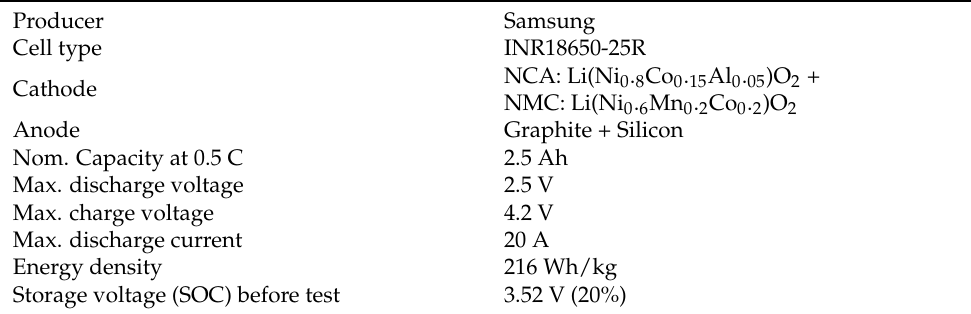
Table 1. Specifications of the used Samsung battery.